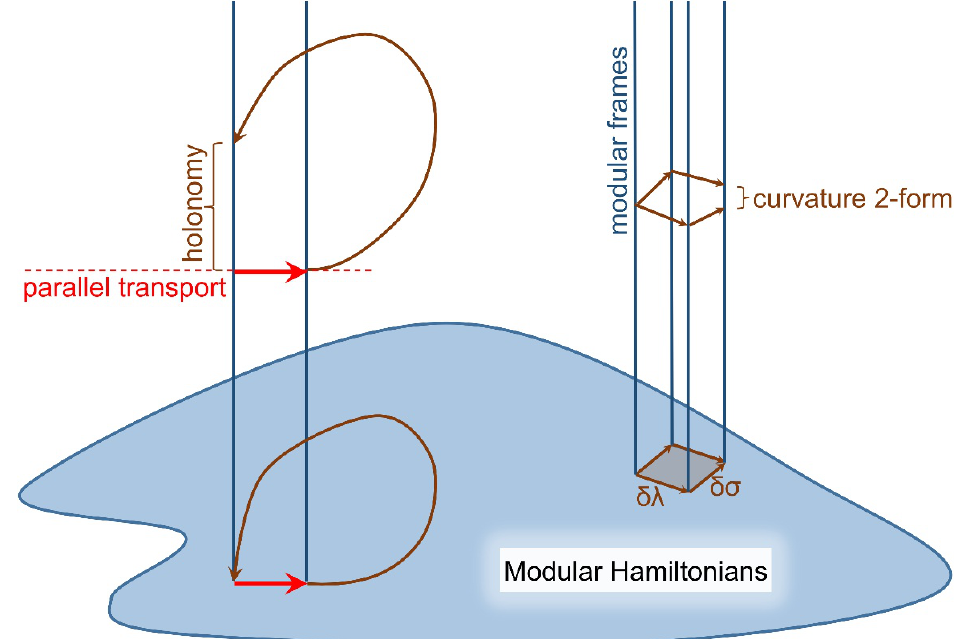
Figure 2 . The (cid:12)ber bundle studied in this paper. The base comprises di(cid:11)erent modular Hamilto- nians and the (cid:12)bers are modular zero mode